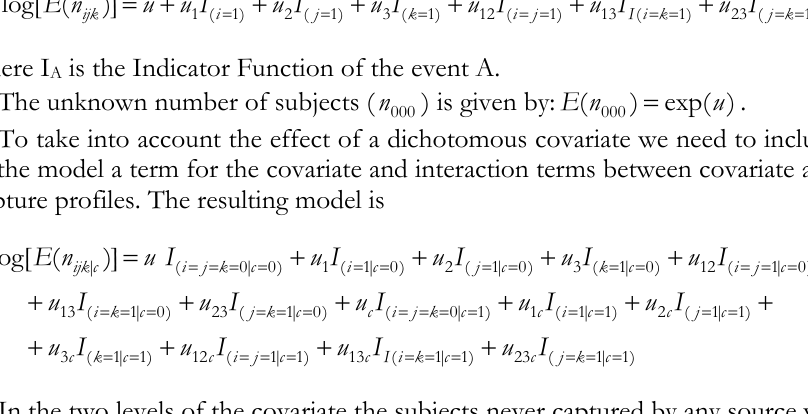
Capture 1 Capture 3 Capture